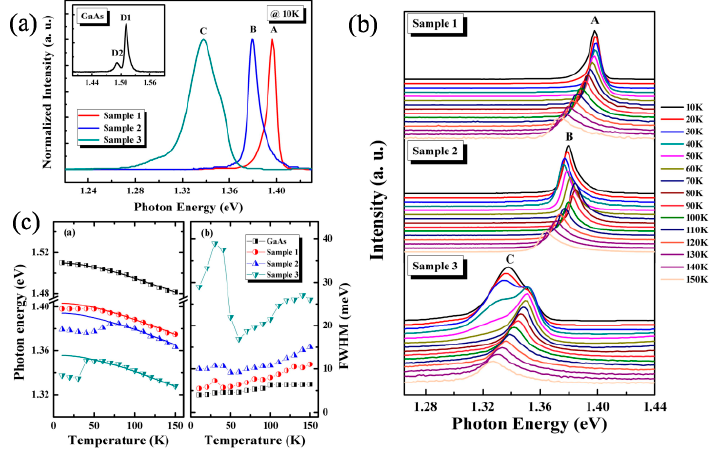
Figure 8. ( a ) PL spectra of GaAs x Sb 1 − x alloy samples at 10 K; the inset shows the PL spectrum of GaAs substrate at 10 K, ( b ) temperature-dependent PL characteristics of GaAsSb, and ( c ) (i) temperature dependent peak position and (ii) temperature dependent FWHM of the samples. Reproduced with permission from [22], copyright Nature Publishing Group (2016).